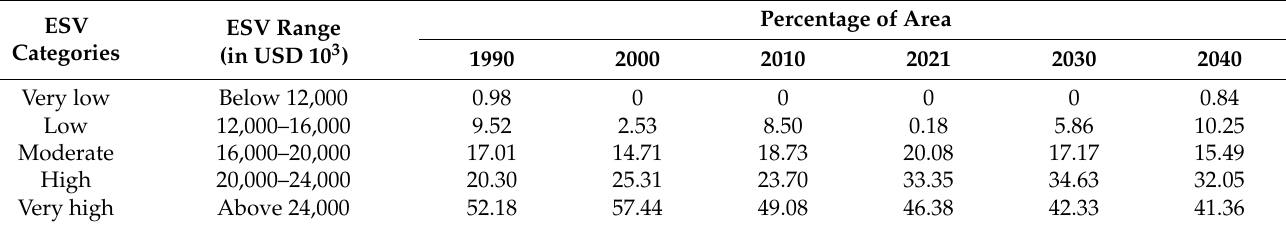
Table 10. Spatio-temporal variation of ESV as per Costanza et al.